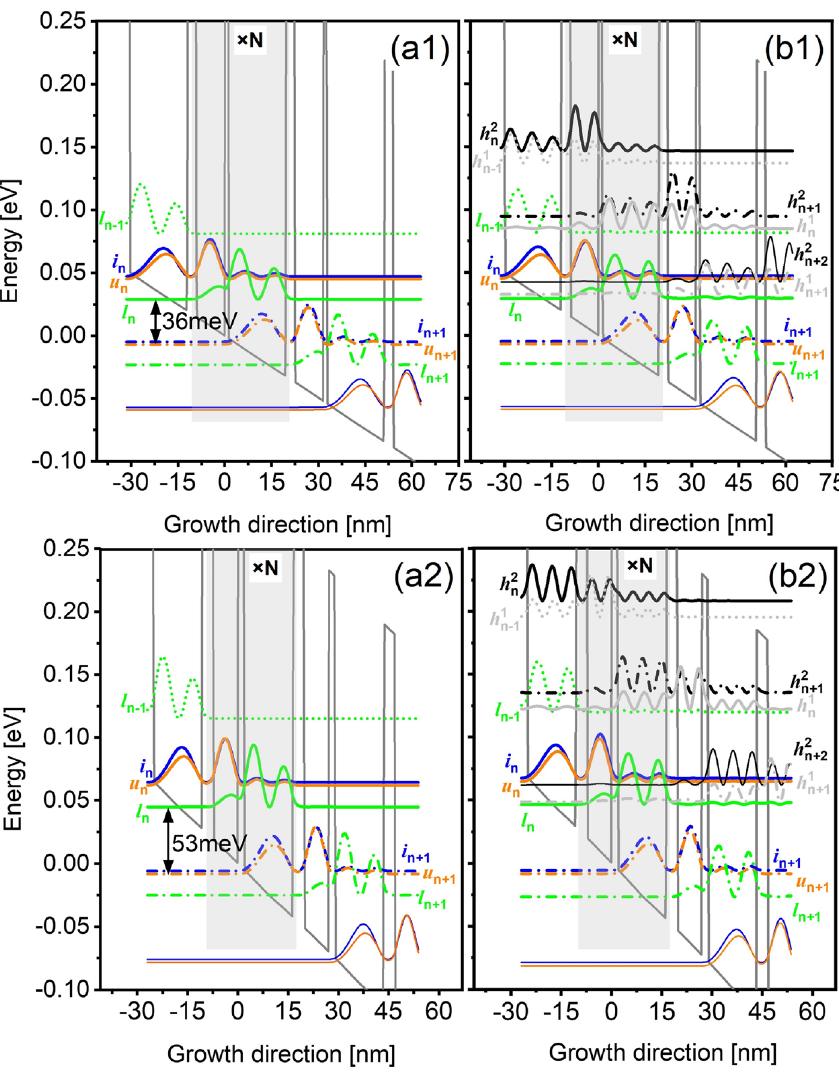
Figure 1. GaAs/Al 0.3 Ga 0.7 As conduction band diagram of the short-period resonant-phonon design at an operating bias within three neighboring periods ( n − 1, n , and n + 1). Two different designs are shown with the depopulation energy of 36 meV and 53 meV, respectively. The widest wells in both designs are locally doped with a 2D electron density of 4.6 × 10 10 cm −2 . The wavefunctions of confined subbands in quantum heterostructures are displayed, such that ( a1 , a2 ) only contains three relevant subbands in the model, the injector subband i , the upper-laser subband u and lower-laser subband l , as [ i , u , l ] ( b1 , b2 ) beside the relevant subbands, also the HLS are involved in the model, as [ i , u , l , h 1 , h 2